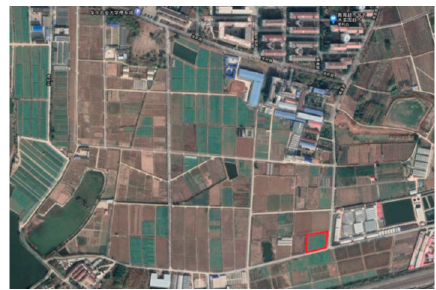
Figure 11. Experimental field.